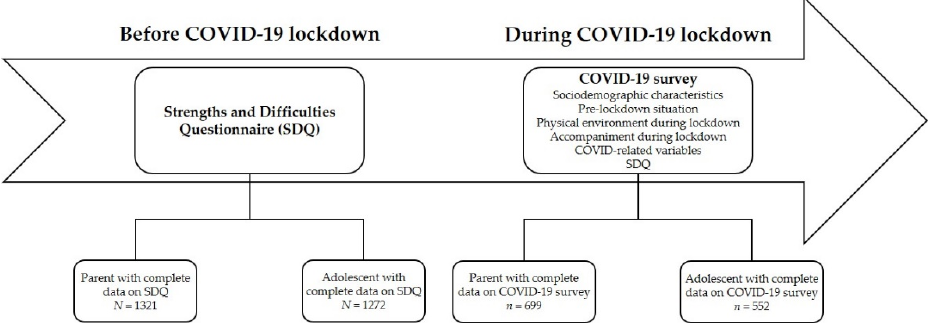
Figure 1. Diagram of the study design